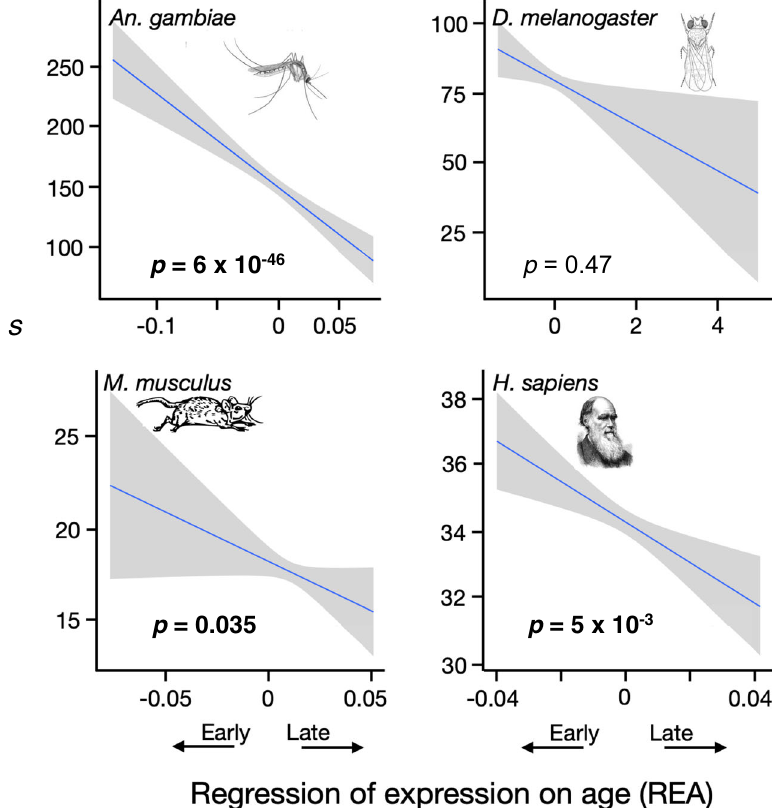
Fig. 5 Selection on late genes is weaker. The relative strength of selection is signi fi cantly weaker in late-expressed genes than early-expressed genes in three of the four species. The estimates of N e s are based on a highly simpli fi ed model that assumes bene fi cial mutations have fi tness effect s and deleterious mutations fi tness – s . Signi fi cance was determined by Spearman rank correlations, and p -values in bold are signi fi cant at p < 0.05 (two-sided tests, not corrected for multiple tests). The lines are least squares regressions, and the gray regions show the approximate 95% con fi dence intervals for the regressions. See also Supplementary Fig. 5 and Supplementary Table